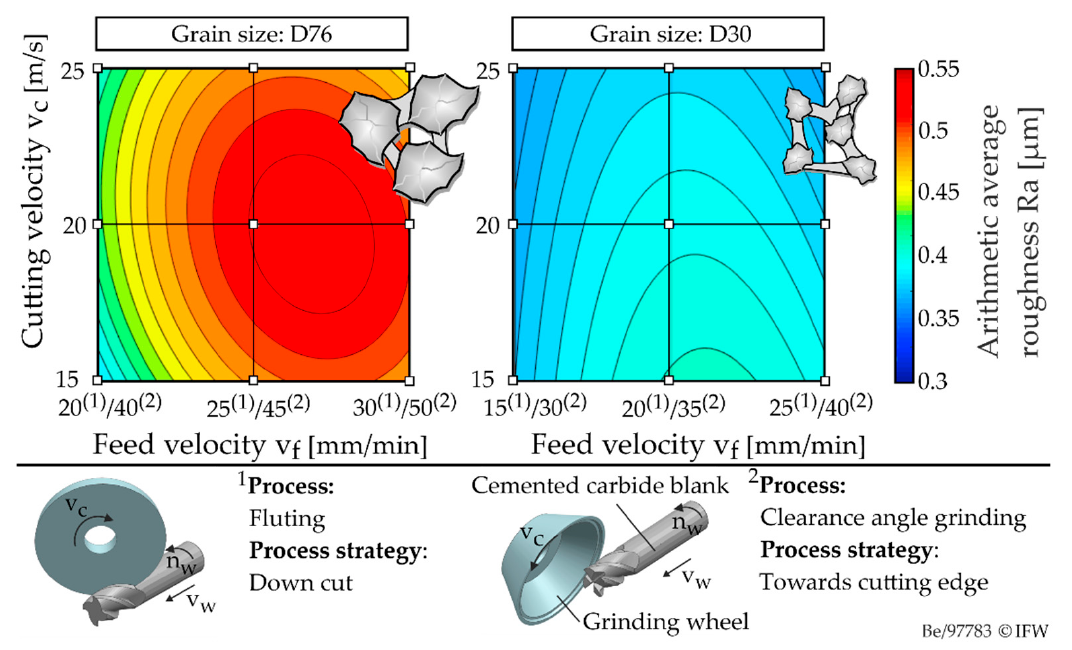
Figure 4. Influence of the process parameters and the grain size during grinding.